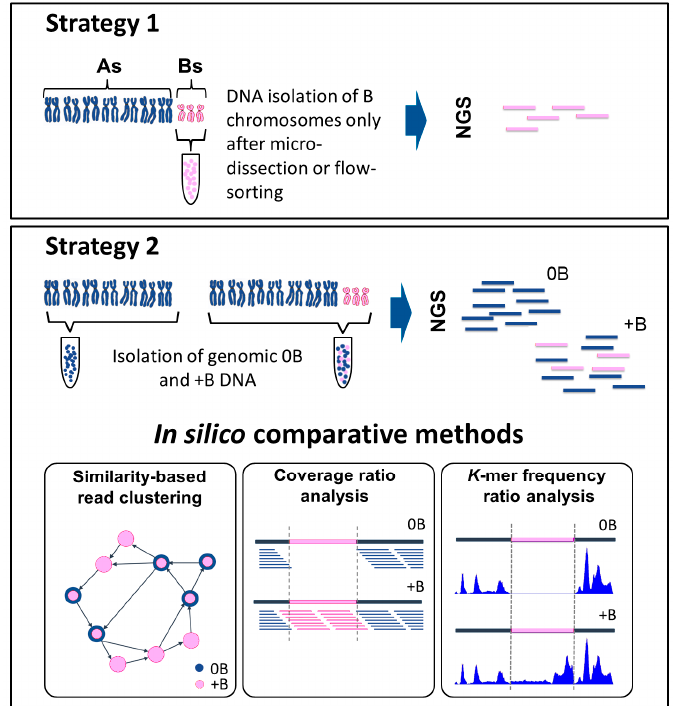
Figure 1. Direct and indirect methods used to identify B chromosome sequences using next generation sequencing (NGS). Strategy 1: the direct method. This approach requires a prior step, in which the B chromosomes are isolated either by micro-dissection or by flow-sorting. Strategy 2: the carrying a B chromosome(s) (+B dataset) and a related individual lacking any B chromosome(s)